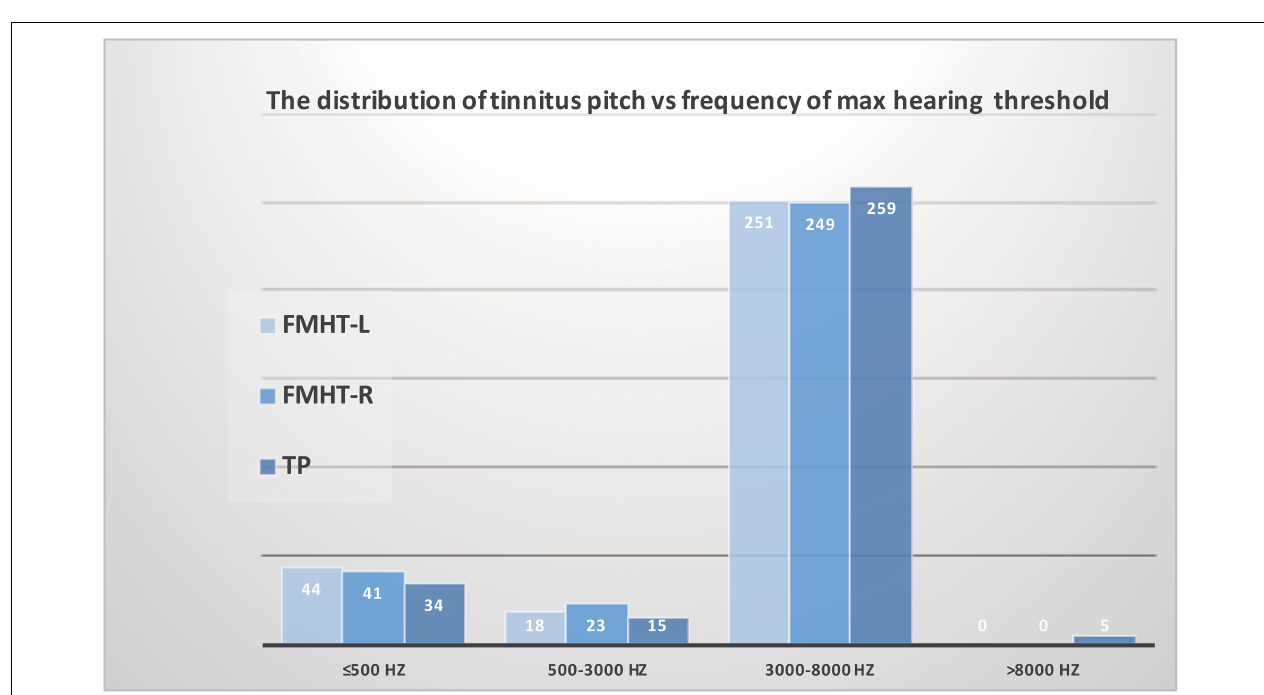
was examined in patients with ultra-high-pitched